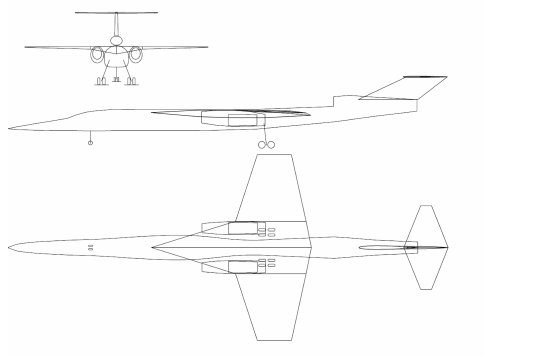
Figure 2. Aircraft design geometry and key